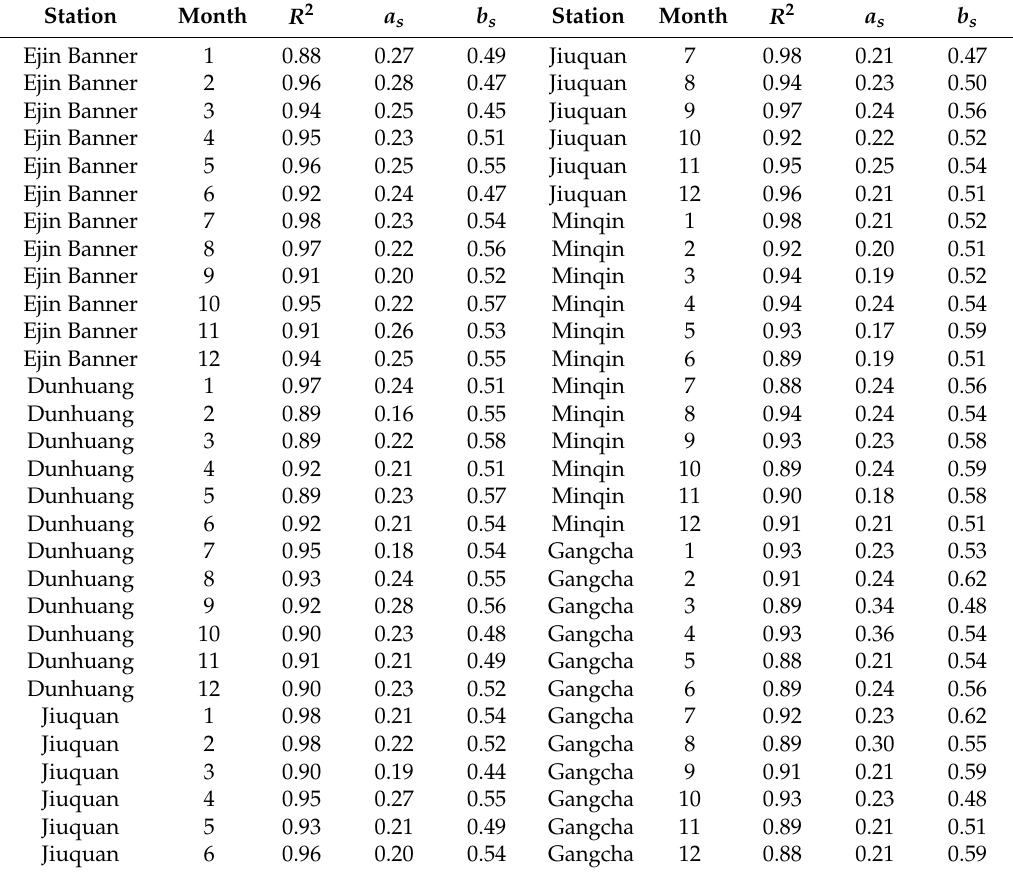
Table 4. Monthly regression Angstrom coefficients of a s and b s at five national radiation stations.